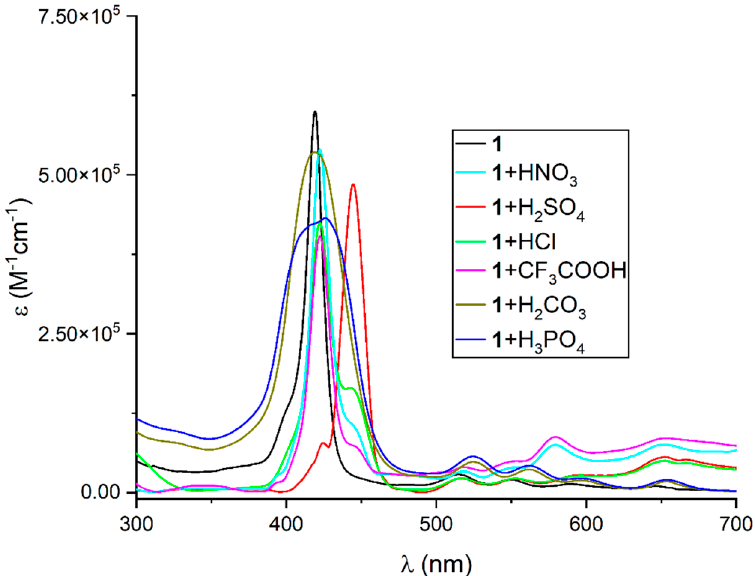
Figure 1. UV-visible spectra of compound 1 and its different ionic complexes in CHCl 3 .